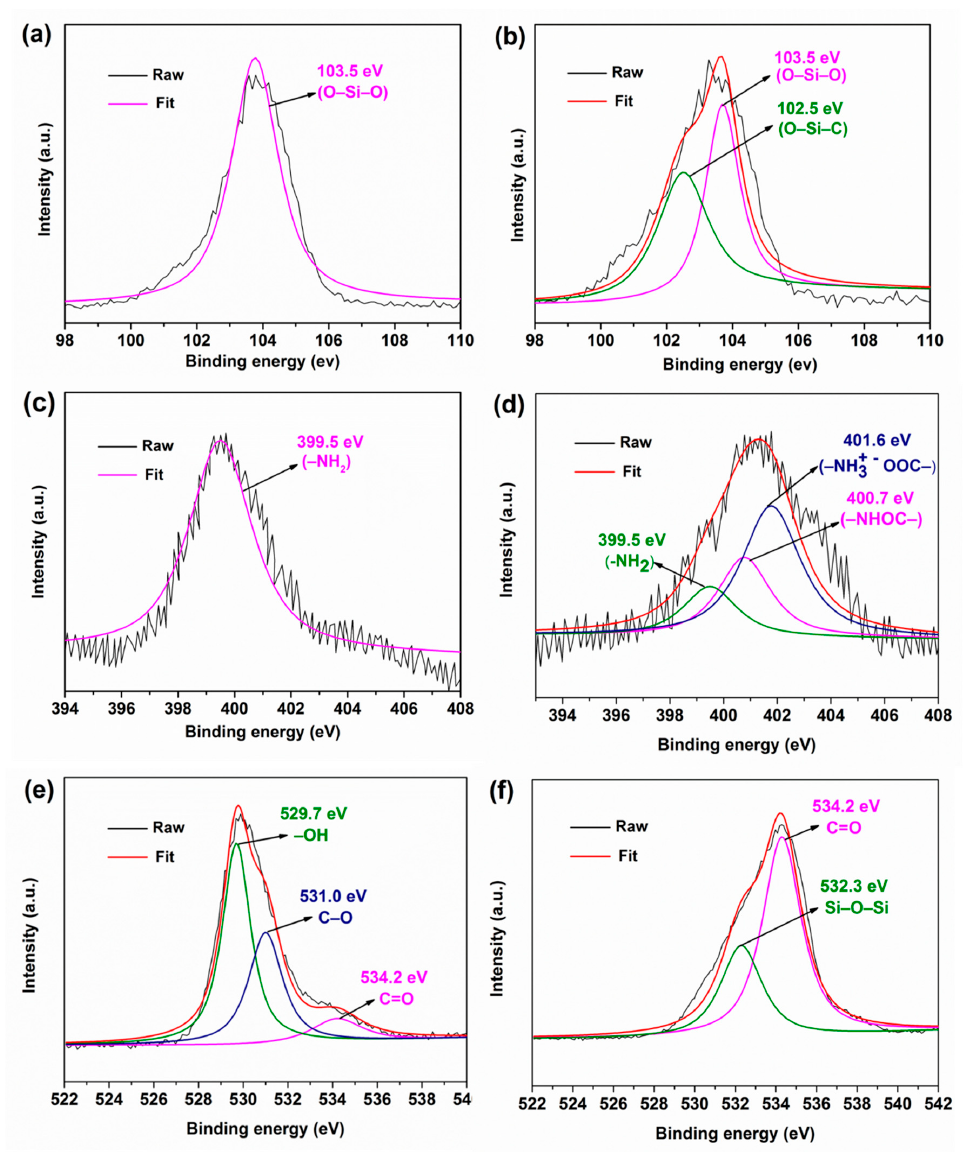
Figure 4. X–ray photoelectron spectroscopic (XPS) survey curves of ( a ) Si2p of SiO 2 , ( b ) Si2p of APES– SiO 2 , ( c ) N1s of APES–SiO 2 , ( d ) N1s of SiO 2 @AF, ( e ) O1s of PAA–AF and ( f ) O1s of SiO 2 @AF.